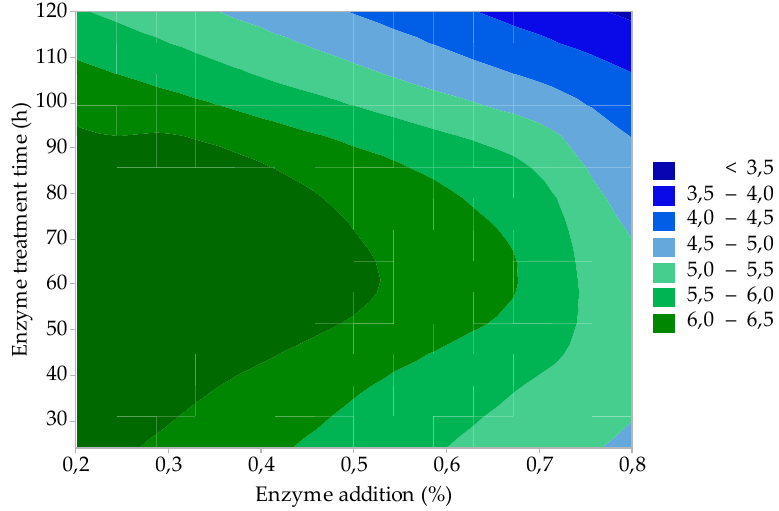
Figure 3. E ff ect of enzyme addition and enzyme treatment time on the gelatine viscosity (study of the influence of process factors).